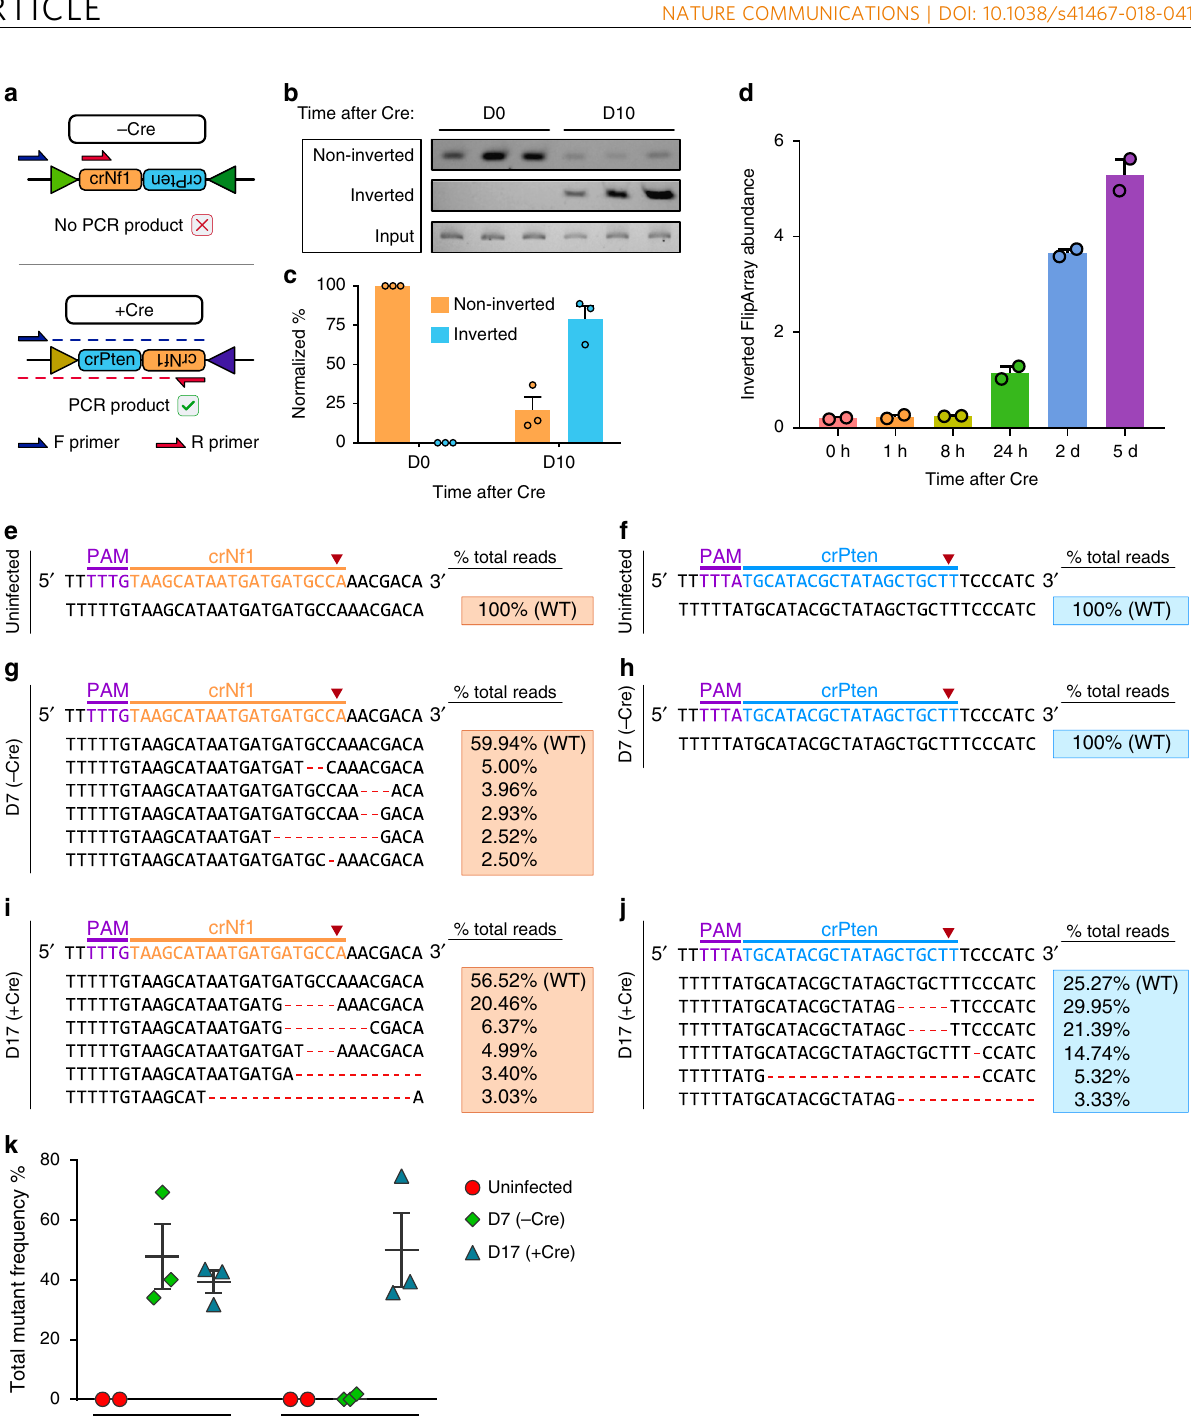
after infection with lentivirus containing EFS-Cpf1-puro; U6-NPF-FlipArray and 10 days following EFS-Cre infection. Where relevant, the top fi ve most frequent variants are shown, with the associated variant frequencies in the boxes to the right. k Dot plot detailing the total variant frequencies at the crNf1 and crPten target sites in uninfected cells (red), 7 days after FlipArray transduction ( − Cre) (green), and 17 days after FlipArray transduction ( + Cre) (blue). n = 2 cell replicates for uninfected group, n = 3 for other conditions. All error bars are mean ±